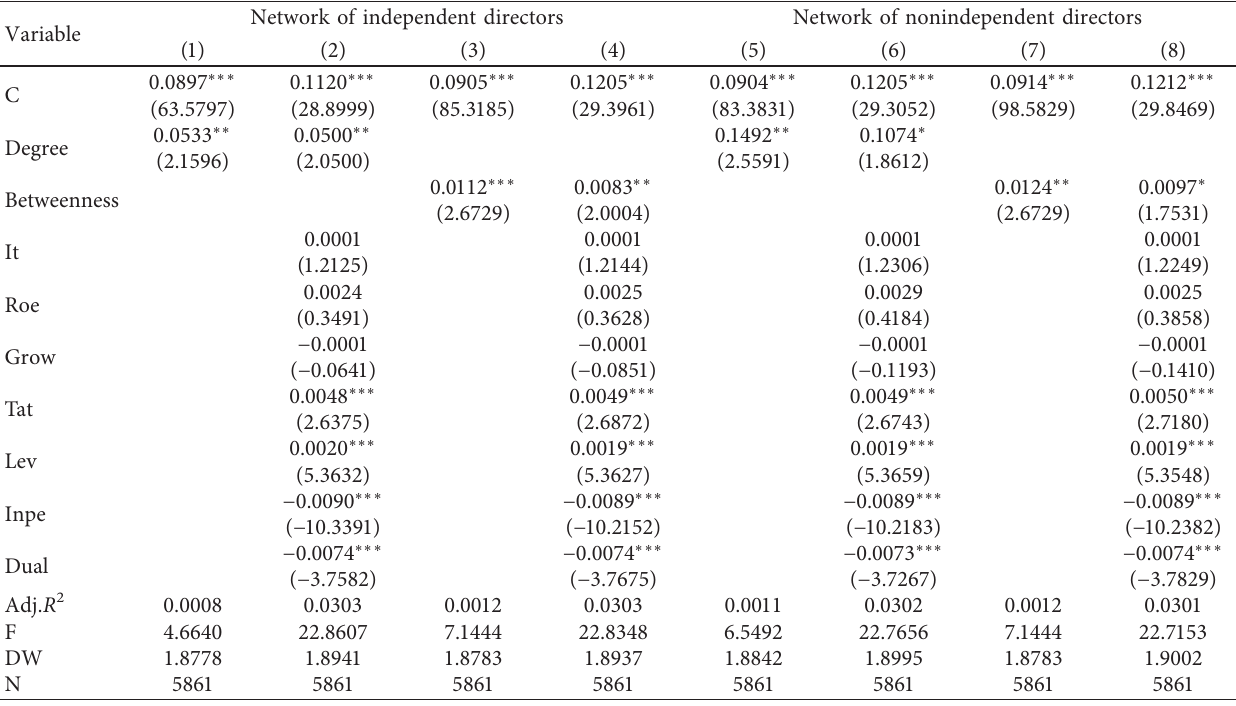
Table 7: Regression results: director networks type and cost of equity